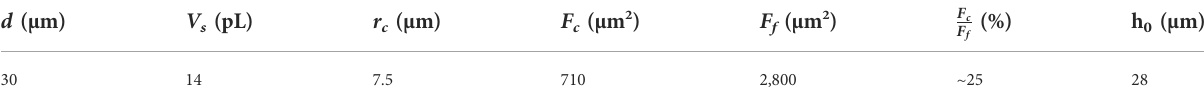
TABLE 1 Parameters for a 14 pL droplet on a SHS with Θ = 150 ° contact angle. V s : volume, F f : surface area of free droplet, F c : contact area. F c /F f is independent of the volume for the geometry shown in Figure 1A (inset); (parameters calculated by G.M.). d ( μ